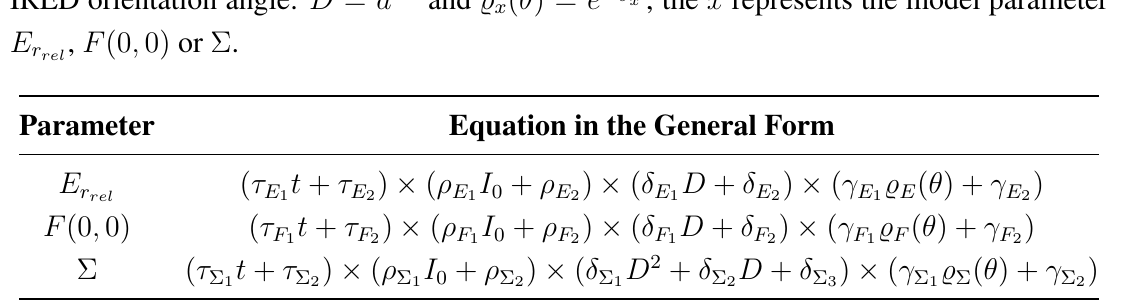
1 θ 2 ( θ ) = e 2 σ 2 x ; the x represents the model parameter x